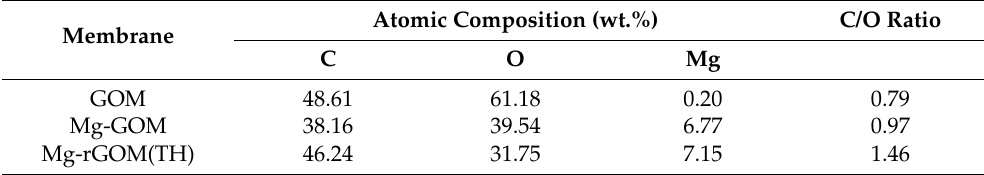
Table 1. Atomic composition of the GOM series obtained from EDX results.